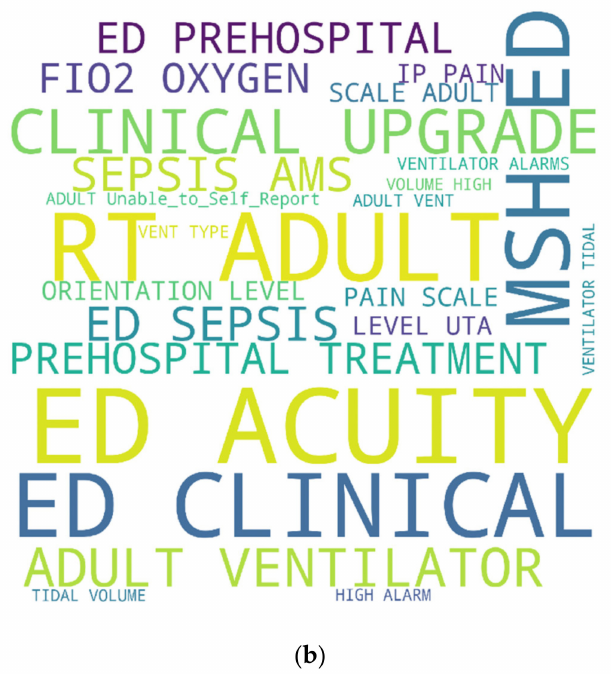
Figure 8. ( a ) Word cloud presentation of words related to 48-h in-hospital mortality. ( b ) Word Cloud of flowsheet terms related to 48-h in-hospital